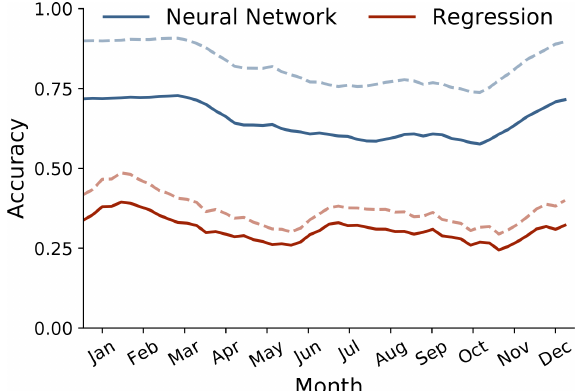
Figure 5. The accuracy of the neural network and multi-output lin- ear regression approaches for each calendar week throughout the year. The neural network accuracy is plotted in blue, and the regres- sion accuracy is plotted in red. The solid lines show the accuracy for all input samples, and the dashed lines show the accuracy if a one-phase error is